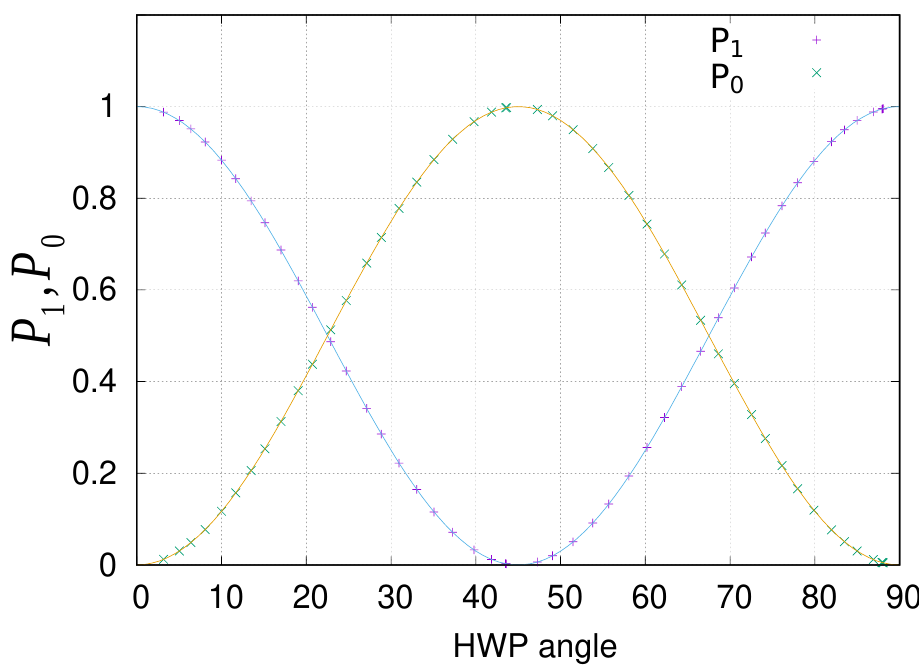
Figure 2. Probability P 1 Equation (1) to detect or not ( P 0 ) single photons in the detector P T . P 0 (green x symbols) and P 1 (red + symbols) as a function of the HWP angle φ /2 can be interpreted as the normalized proportions of 1 (cid:48) s and 0 (cid:48) s stored in the time series to make the statistical analysis of the photon